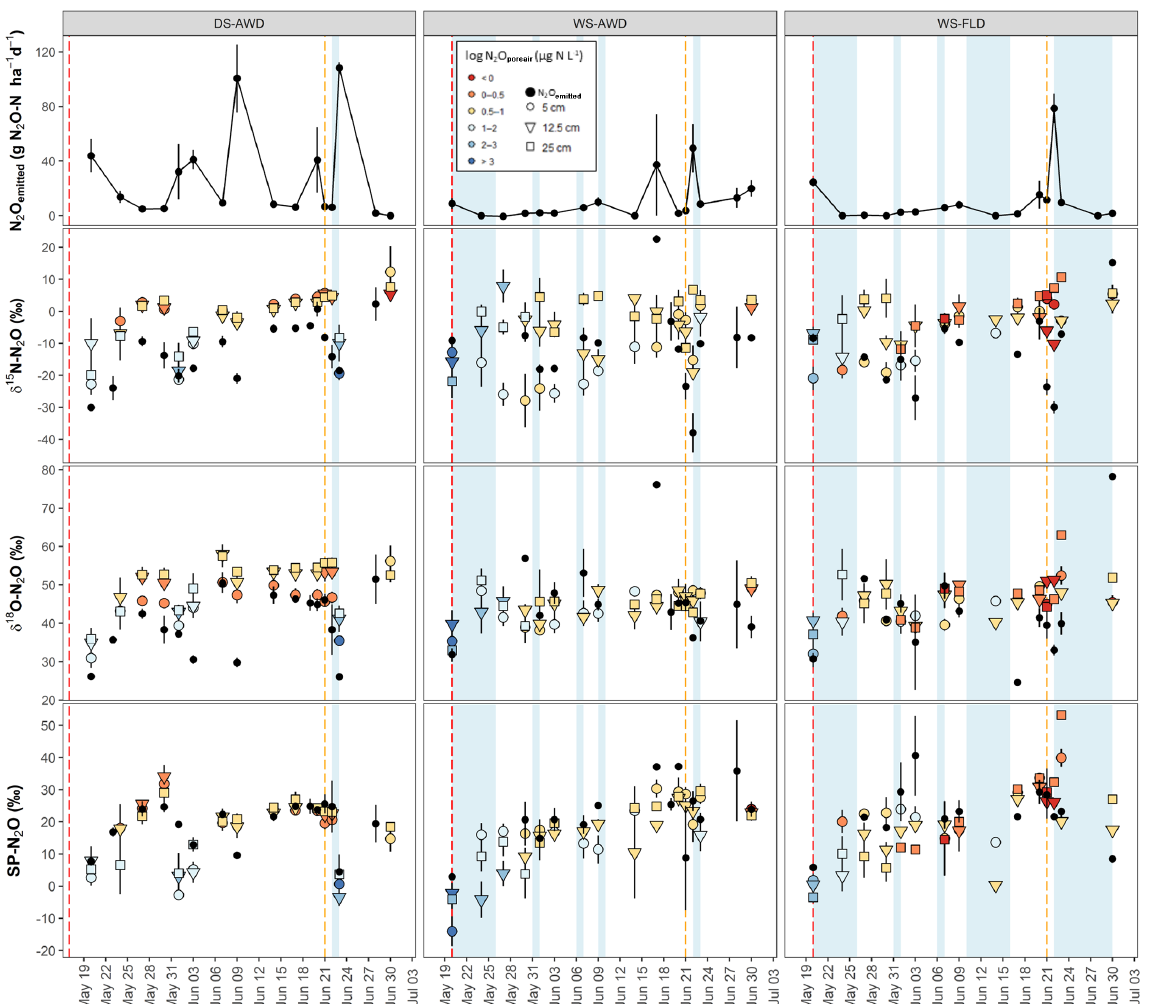
Figure 3. Time course of δ 15 N-N 2 O, δ 18 O-N 2 O and SP-N 2 O in N 2 O emitted and N 2 O poreair across the three depths and water management treatments (WS-FLD: water-seeding + conventional flooding; WS-AWD: water-seeding + alternate wetting and drying; DS-AWD: direct dry seeding + alternate wetting and drying). The error bars represent the standard error of the mean. Red and orange dashed vertical lines represent the date of seeding and fertilization in each treatment,